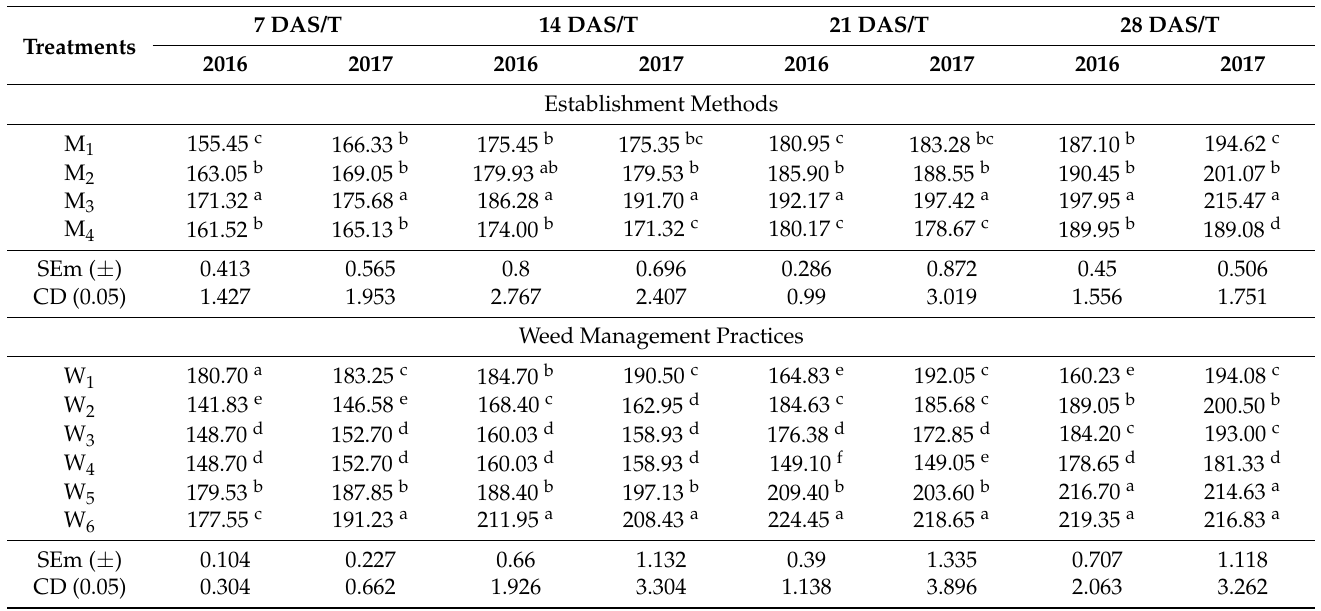
Table 9. The activity of soil enzyme alkaline phosphatase in rice as influenced by crop establishment methods and weed management